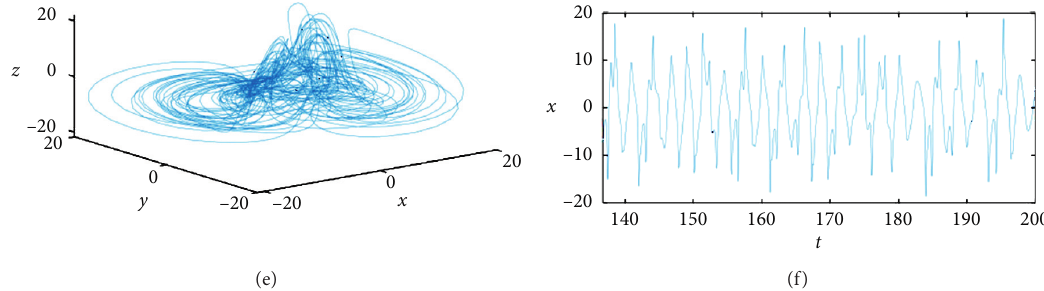
Figure 4: Phase diagram and time course diagram of the system for different values of time-lag risk intensity d . (a) Phase diagram of the system at d � 0.5. (b) Time course diagram at d � 0.5. (c) System phase diagram at d � 2. (d) Time course diagram at d � 2. (e) System phase diagram at d � 4. (f) Time course diagram at d � 4.